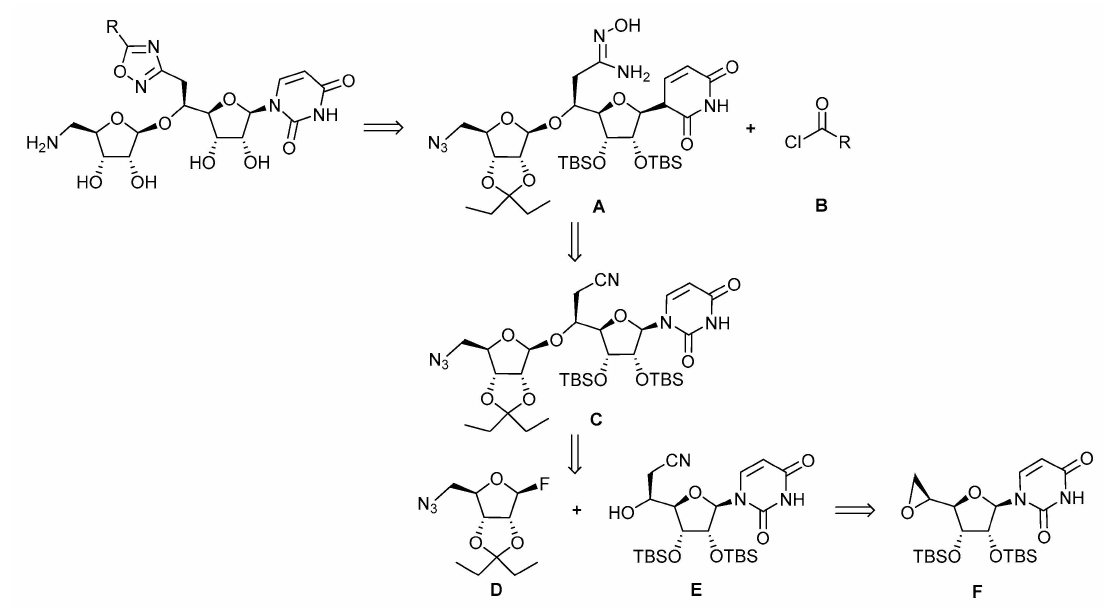
Figure 2. Retrosynthesis of the targeted oxadiazole inhibitors.